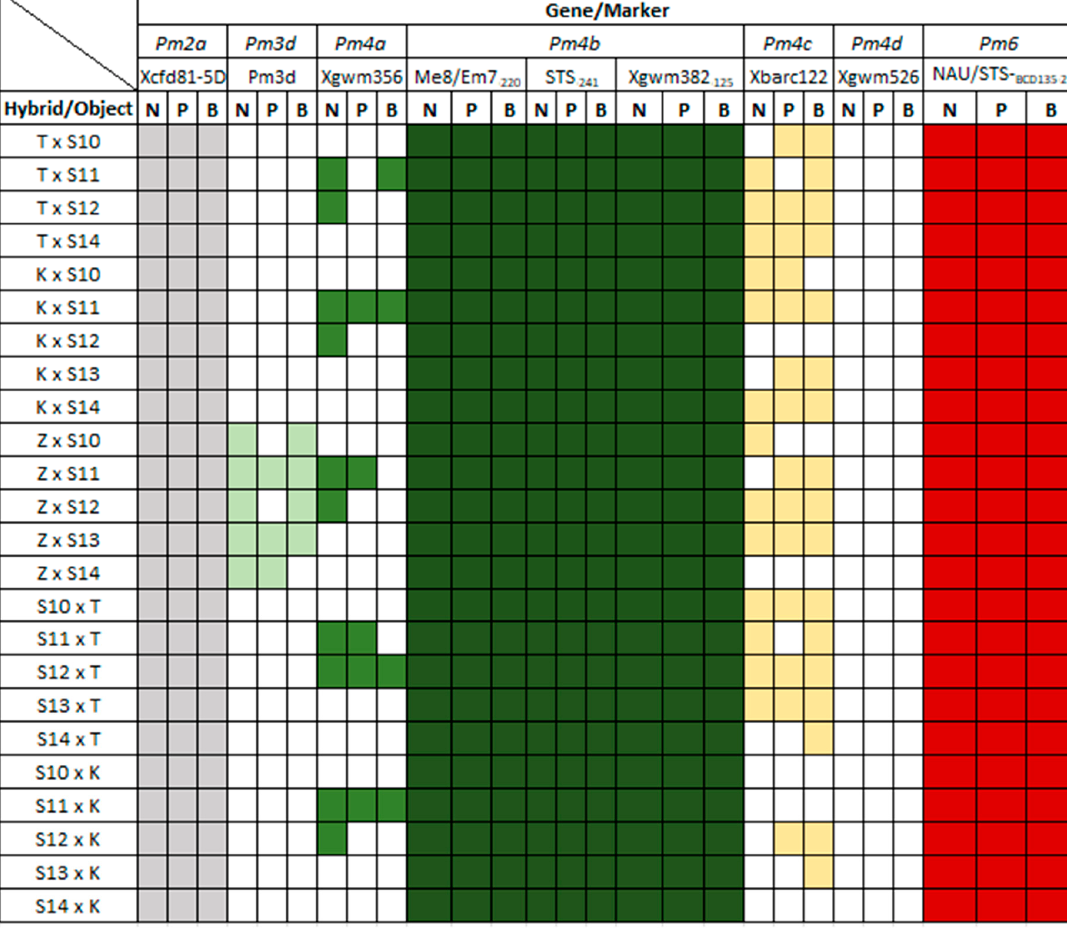
Figure 6. Identification of gene markers associated with wheat resistance to B. graminis f. sp. tritici in bread wheat and spelt lines Key: T—cv. Torka, Z—cv. Zebra, K—cv. Kontesa, N—null lines (e.g., T x S10 is abbreviated as 1), P—prim lines (e.g., T x S10 ′ is abbreviated as 1 ′ ), B—bis lines (e.g., T x S10 ″ is abbreviated as 1 ″ ).